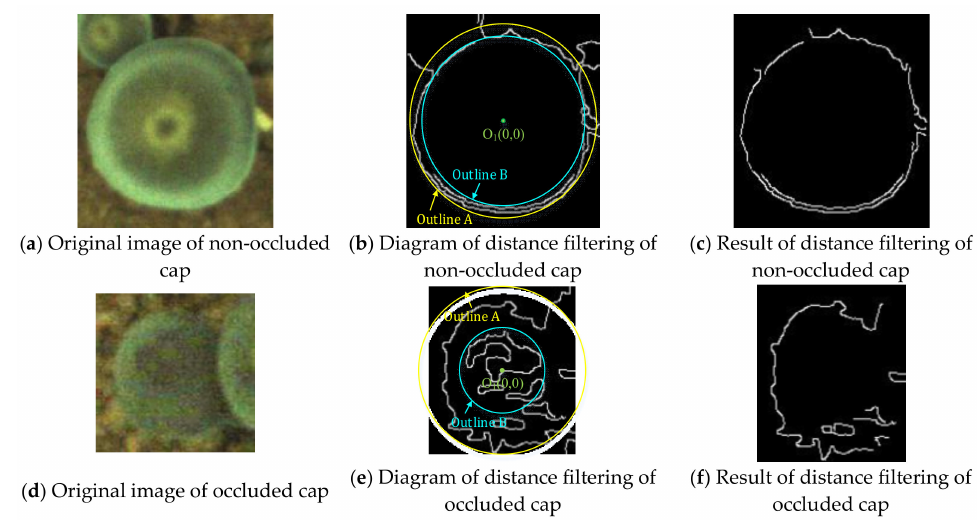
Figure 7. Images of original and distance